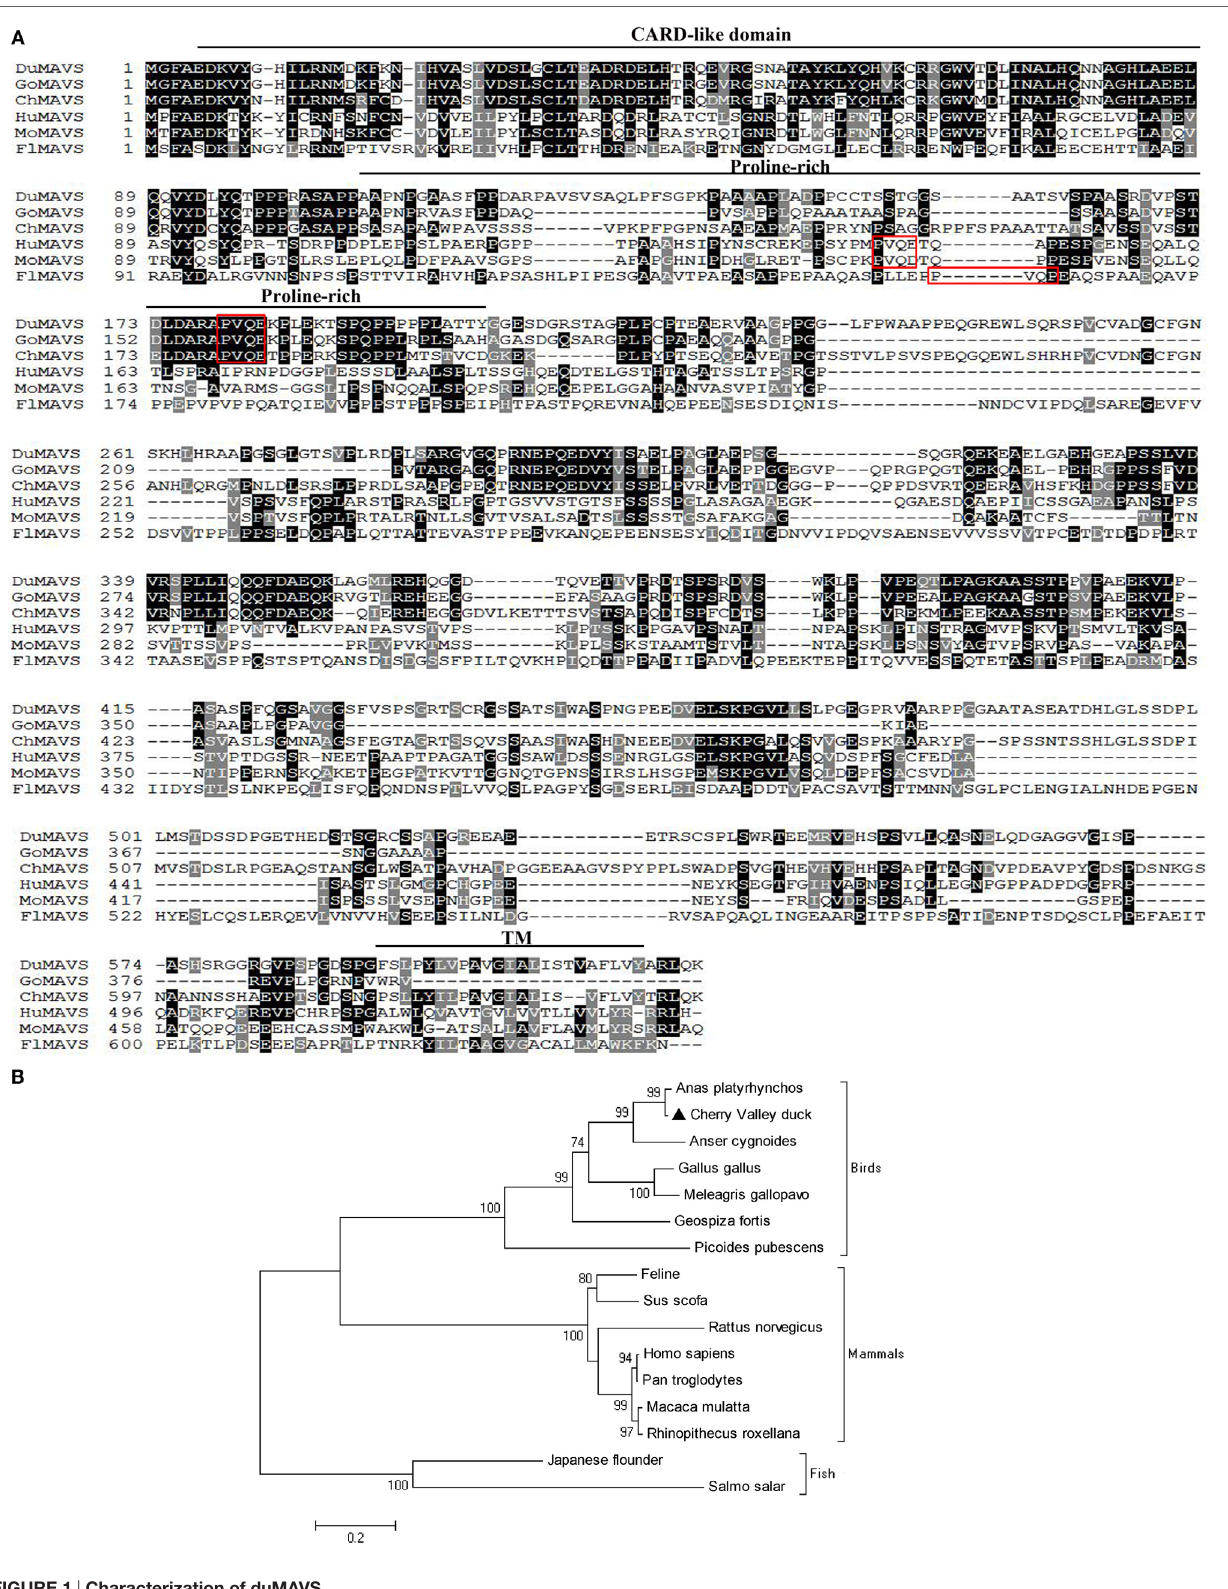
FigUre 1 | characterization of duMaVs